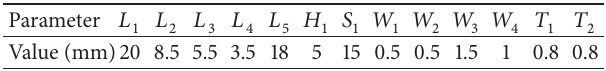
Table 1: Optimized design parameters of the proposed